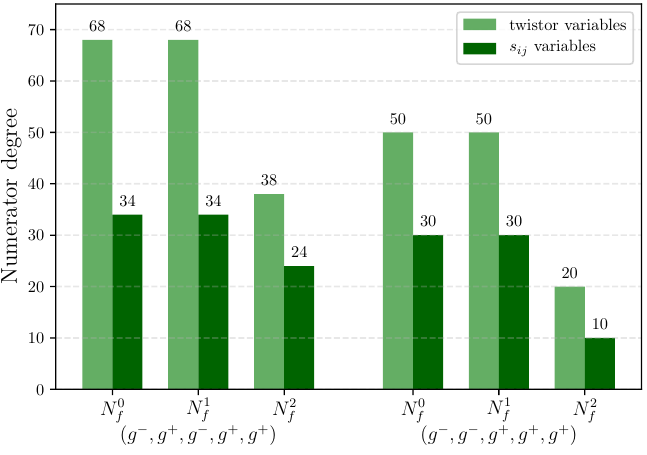
Figure 7 . Maximal degrees of numerators of the two most complicated amplitudes in twistor and s ij variables.